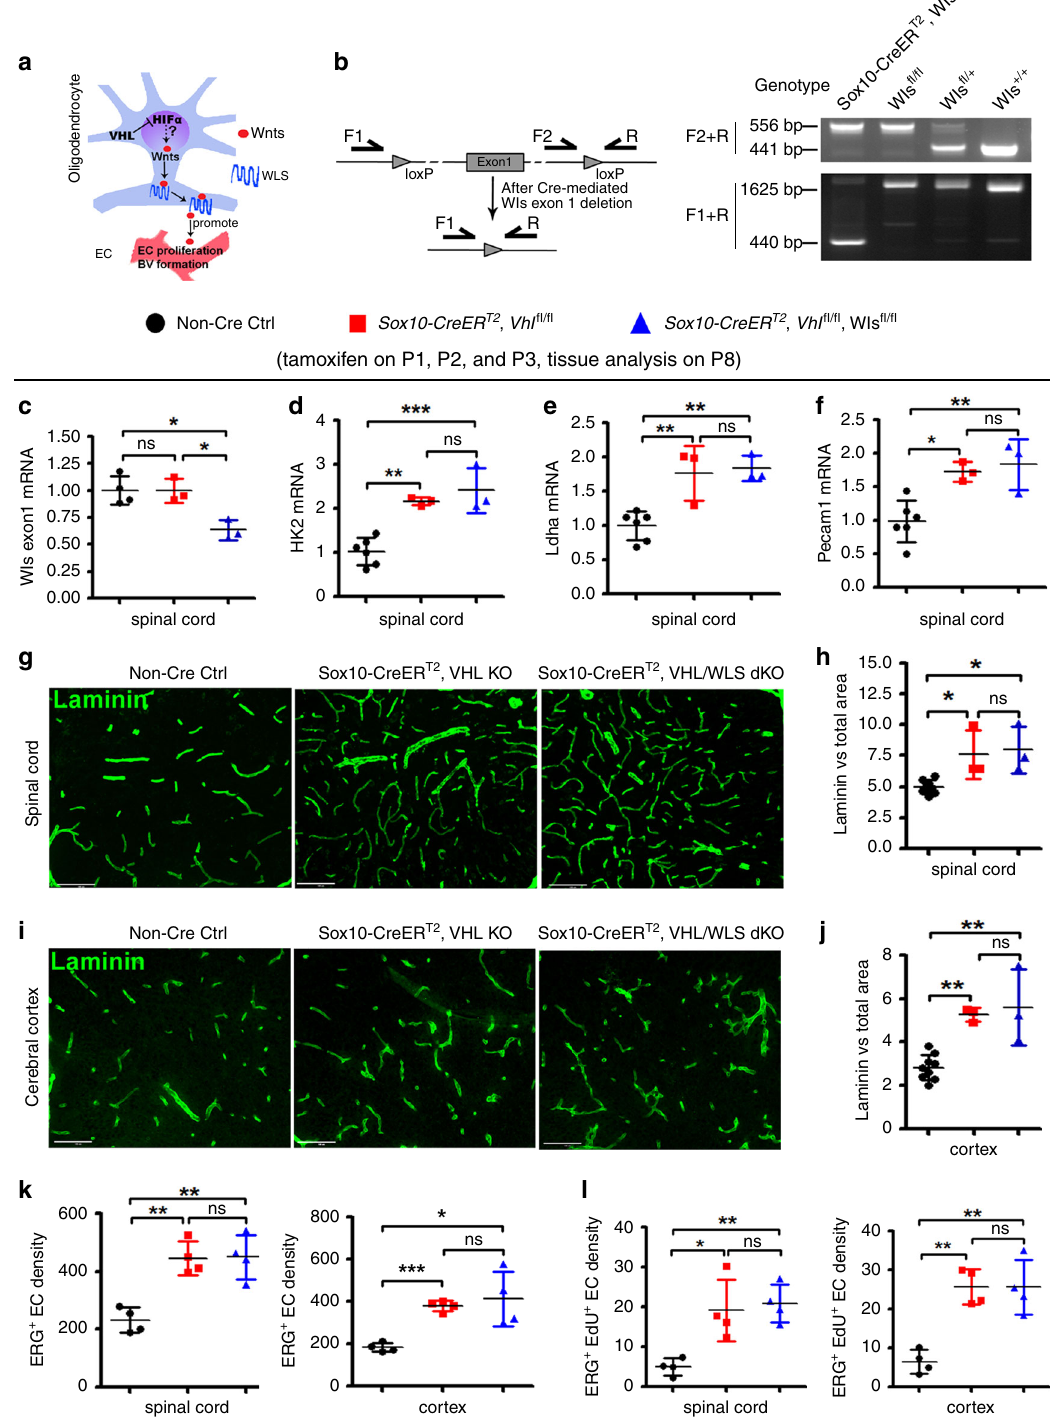
data showed that EYFP reporter, which is an indicator of mGfap- Cre activity, was expressed in GFAP + or S100 β + astrocytes, but not in Sox10 + oligodendroglial lineage cells, NeuN + neurons (Fig. 8a), or ERG + ECs (data not shown) in the spinal cord and the cerebral cortex of adult mGfap-Cre:Rosa26-EYFP mice at P60, con fi rming that mGfap-Cre primarily targets astroglial lineage cells in those CNS regions. We observed a signi fi cant increase in the density of Laminin + blood vessels (Fig. 8b, c) and in the mRNA expression of EC-speci fi c NATURE COMMUNICATIONS| (2020) 11:2027